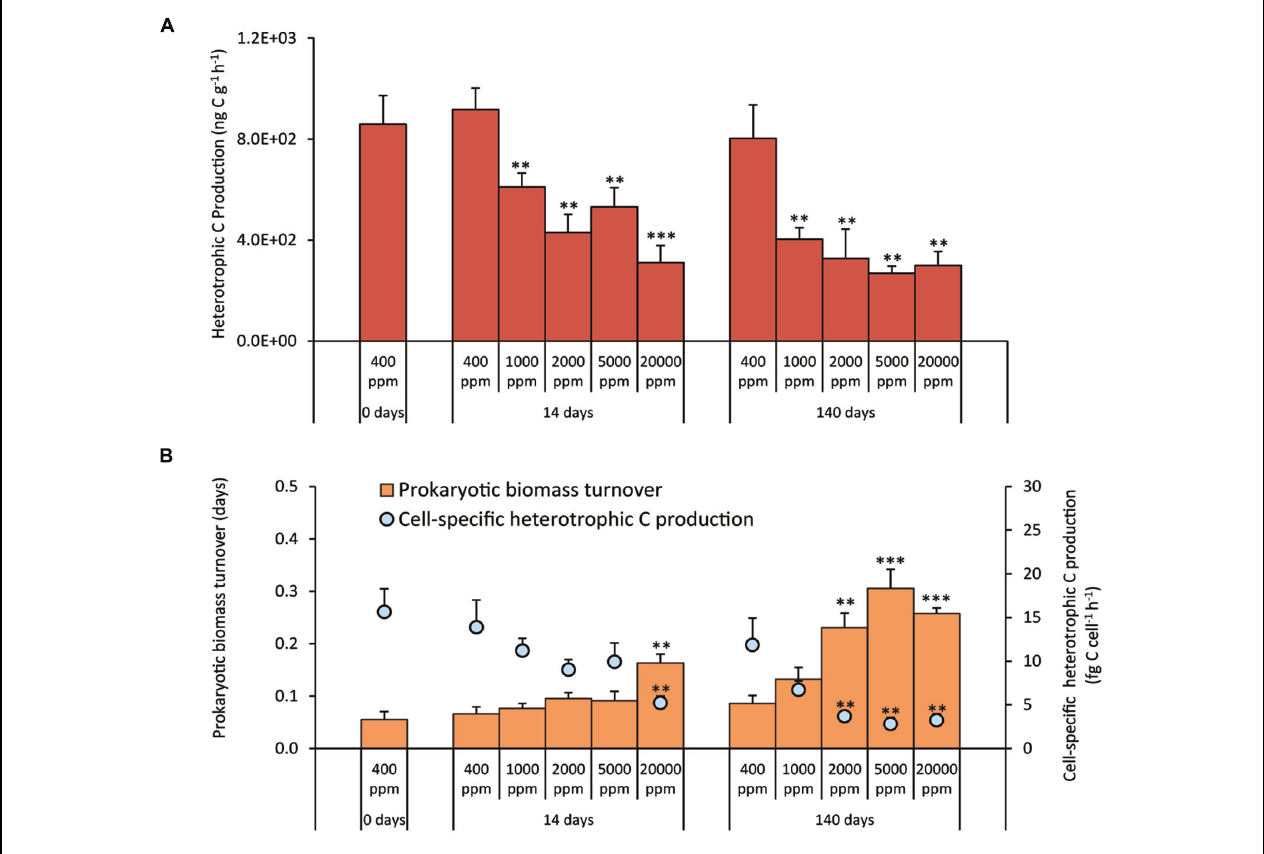
FIGURE 4 | (A) Heterotrophic Carbon Production, and (B) cell-specific Heterotrophic Carbon Production and prokaryotic biomass turnover time in the different high-CO